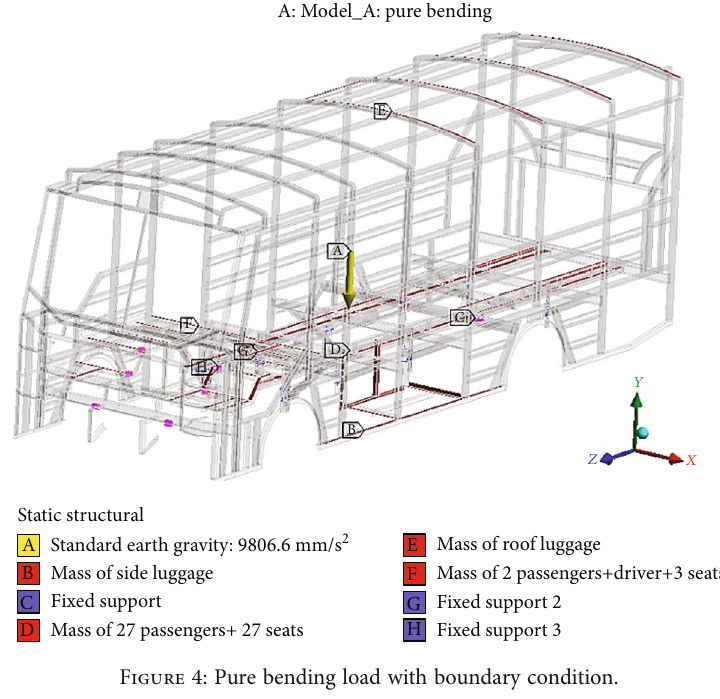
Figure 4: Pure bending load with boundary condition.